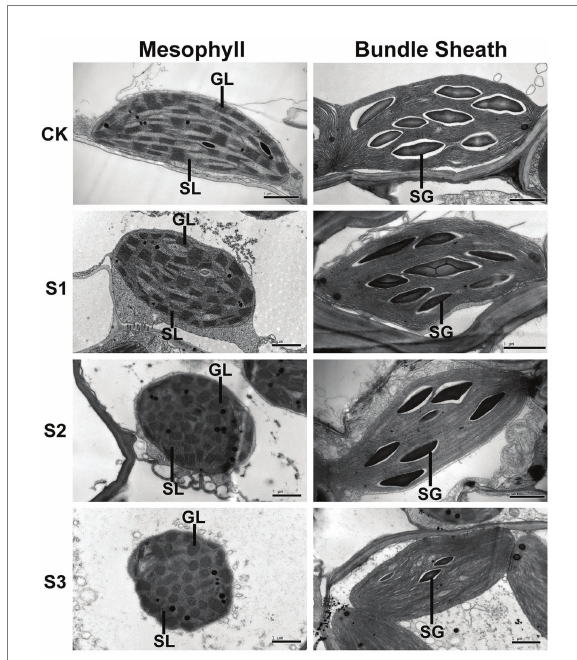
FIGURE 8 Transmission electron microscope analysis of chloroplasts in maize leaves exposed to progressive drought stress. GL and SL represent, respectively, the grana lamellae and stroma lamellae of mesophyll thylakoids, and SG represents starch grain. CK, well- watered control; S1, mild drought stress; S2, moderate drought stress; and S3, severe drought